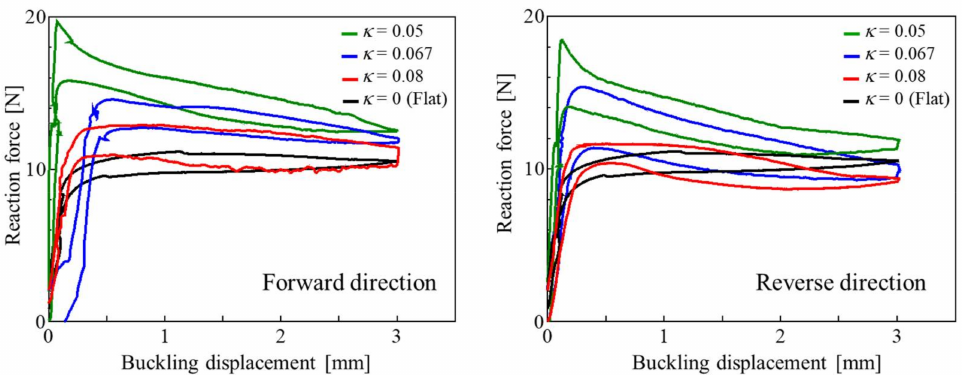
Figure 10. The experimentally obtained relationships between the reaction force and buckling displacement of the flat and convex tape-shaped SMA elements in each buckling direction.